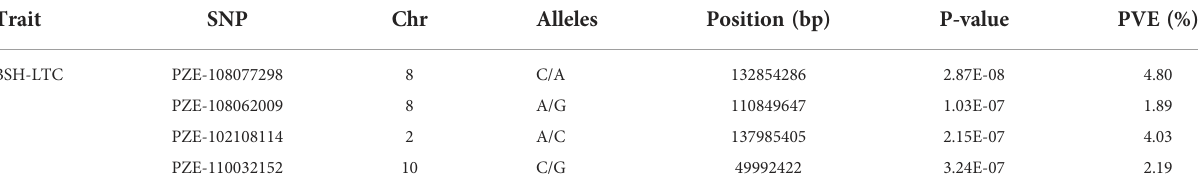
TABLE 2 Signi fi cant SNPs associated with BSH-LTC identi fi ed by GWAS using FarmCPU model. Trait